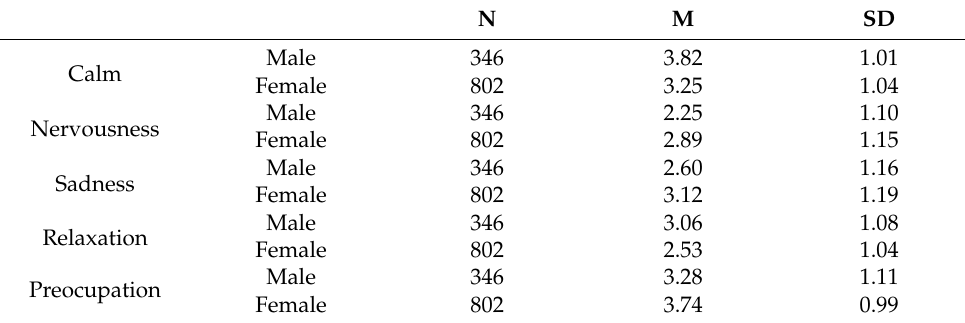
Table 1. Means and Standard deviation of emotions by gender. N M